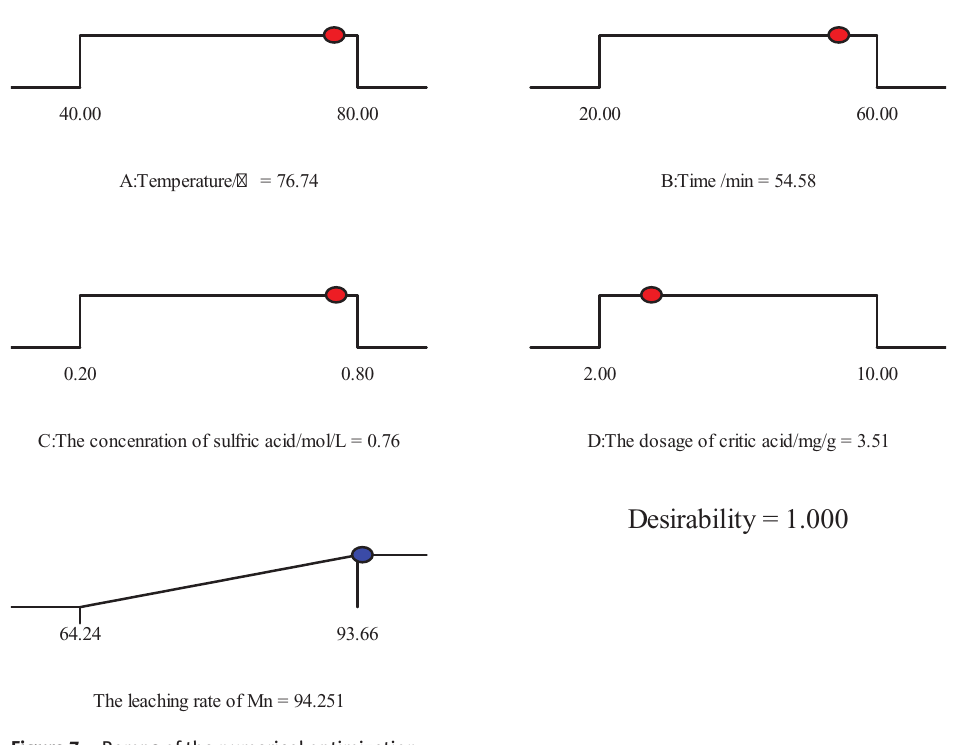
Figure 7: Ramps of the numerical